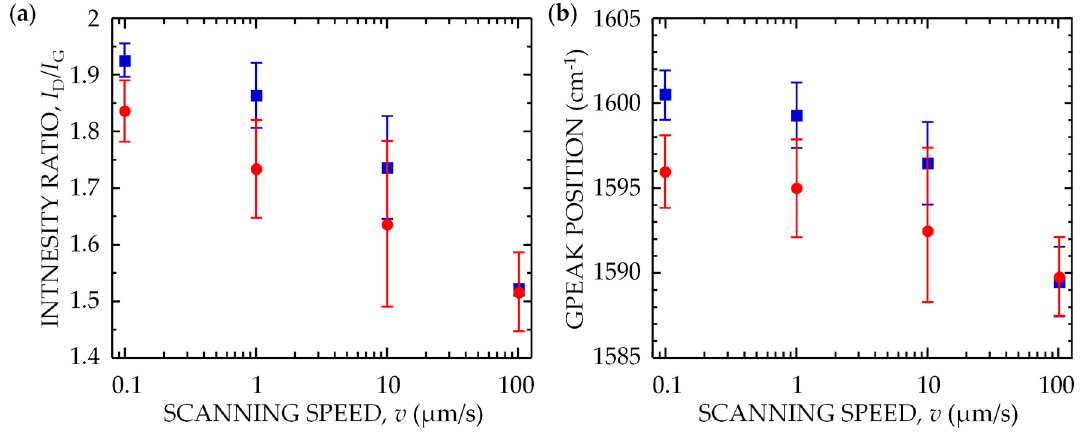
Figure 6. ( a ) Ratio of intensities of D and G peaks ( I D / I G ) and ( b ) position of G peak for DLC films irradiated with 7-fs laser pulses with I = 1 TW/cm 2 at F = 6 mJ/cm 2 (red circles) and those irradiated with 100-fs laser pulses with I = 0.1 TW/cm 2 at F = 6 mJ/cm 2 (blue squares) as function of scanning speed v .